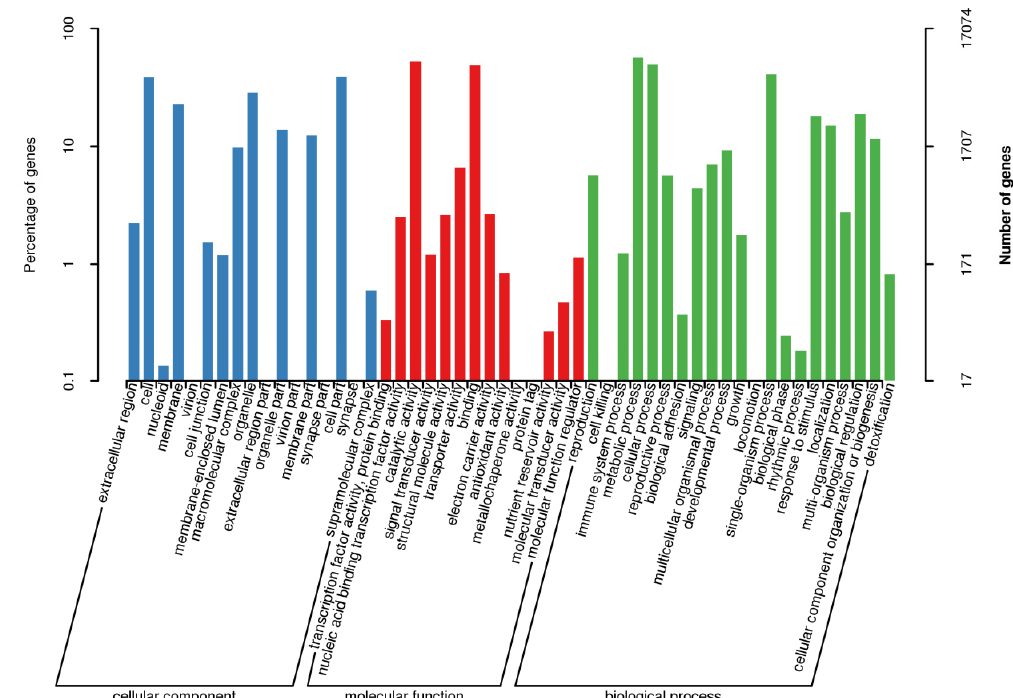
Figure 2. Gene ontology annotation secondary node classification statistics. The abscissa shows the content of each GO category. The left panel of the ordinate shows the percentage of each type of gene, and the right panel shows the number of genes. This figure shows the enrichment of genes for each secondary GO function.